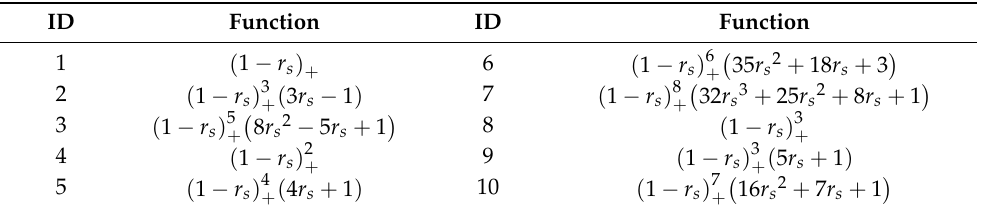
Table 1. Examples of compactly supported RBFs; “+” means value zero out of the scaled distance <0, 1>